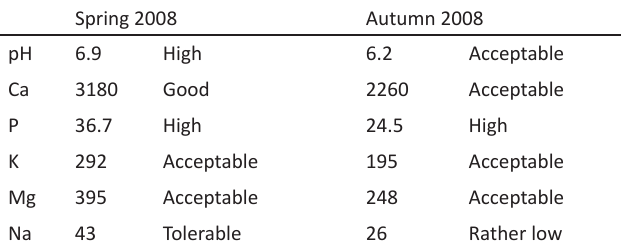
Table 1. Soil analysis results before sowing and after harvest of sugar beet in 2008 (mg l -1 , except pH) (Finnish soil quality classification